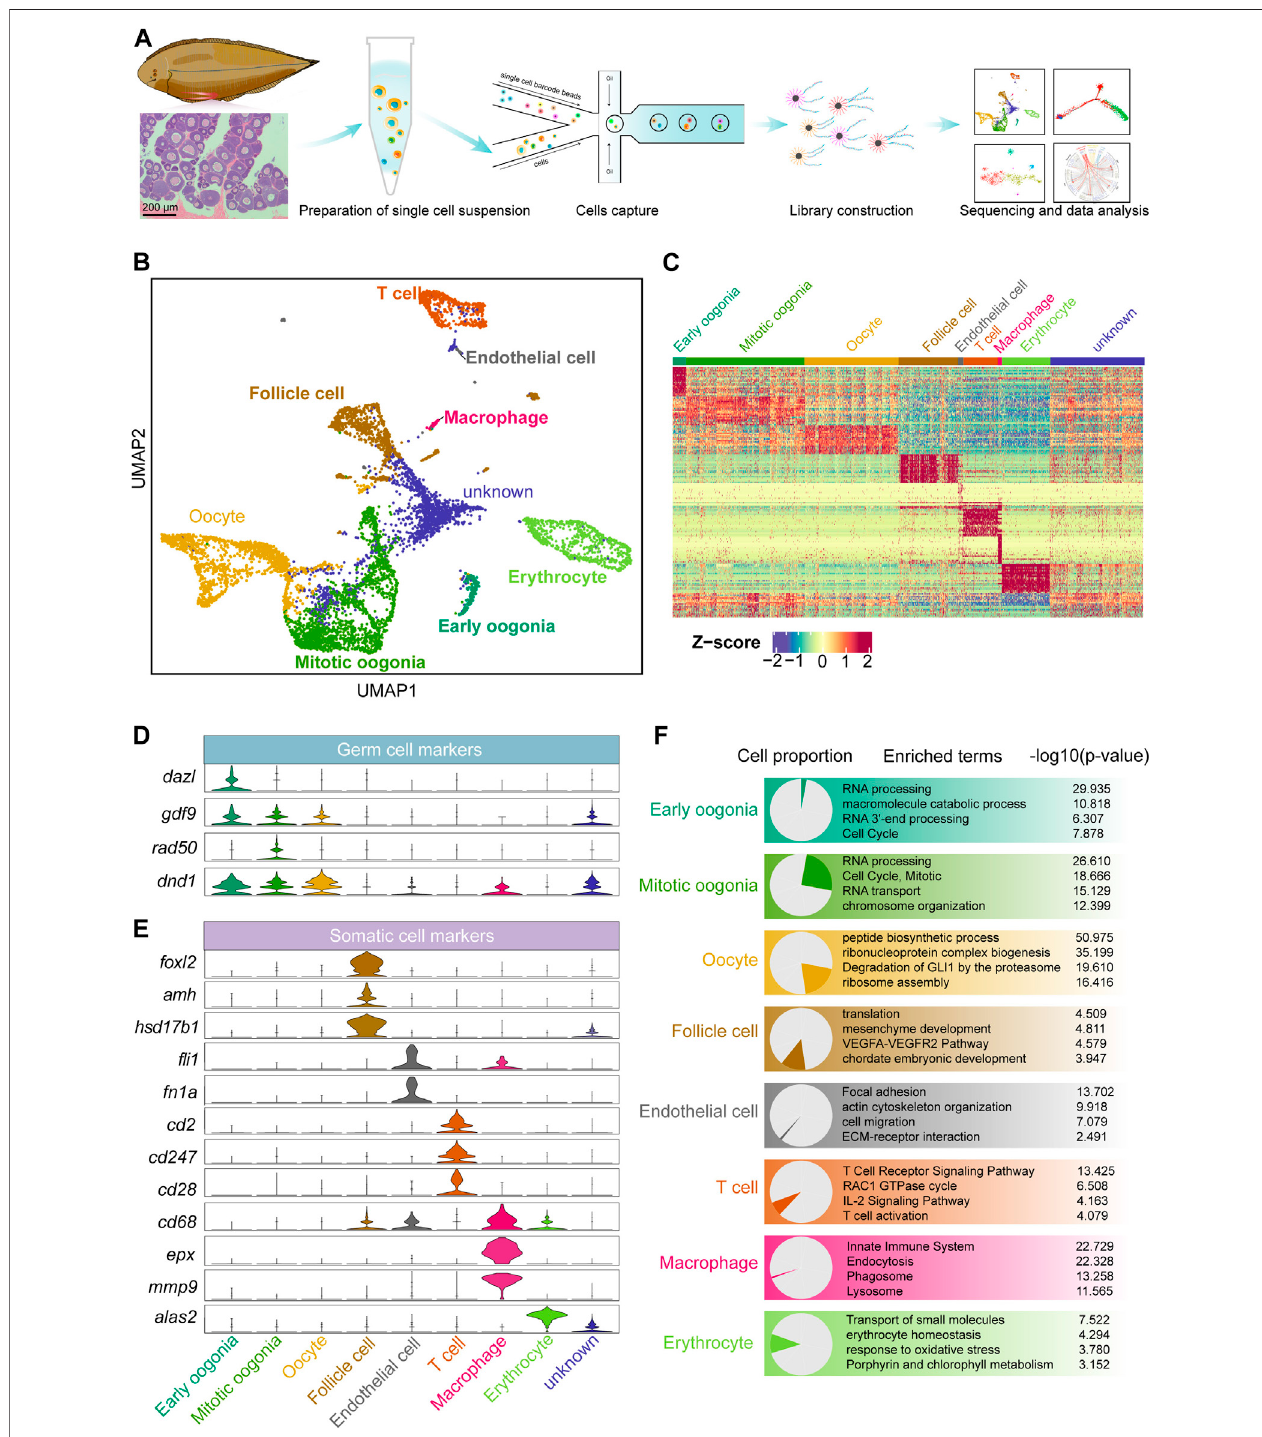
FIGURE 1 | Overview of germ and somatic ovarian cell types determined by scRNA sequencing in Chinese tongue sole. (A) Schematic representation of the scRNA-seq analysis of Chinese tongue sole ovarian cells. (B) Visualization of major ovarian cell types among 7,185 cells in UMAP (unknown is unde fi ned). Different cell typesareshownindistinctcolours. (C) Heatmapshowingtheexpressionofthetop20DEGsofthemaincelltypes.Thecoloursfrombluetoredindicatelowtohighgene expression levels, respectively. Z-scores were calculated by subtracting the average value for the set of data from the value for each cell and dividing by the standarddeviation. (D) Violinplotsofthenormalizedexpressionofmarkergenesinthethreegermcelltypes. (E) Violinplotsofthenormalizedexpressionofmarkergenes in the fi ve somatic cell types. (F) Enriched terms of DEGs are shown for ovarian cell types ( p -values are shown). The proportion of each cell type is shown on the left.